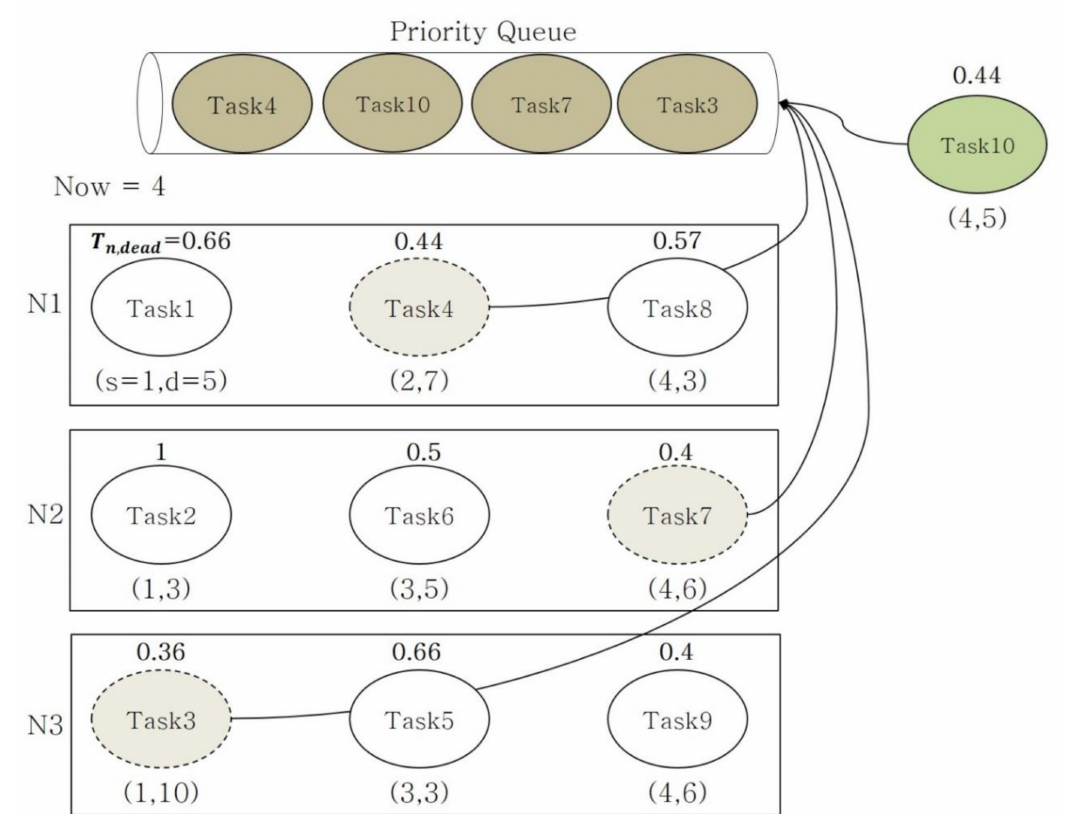
Figure 4. Memory load-based